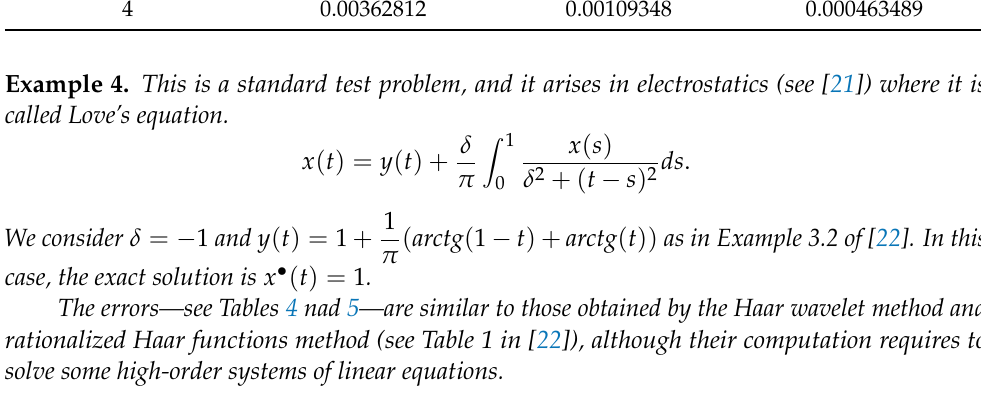
Table 4. (cid:107) x • − x ( n , r ) (cid:107) for Example 4 using the usual basis in C [ 0,1 ] .